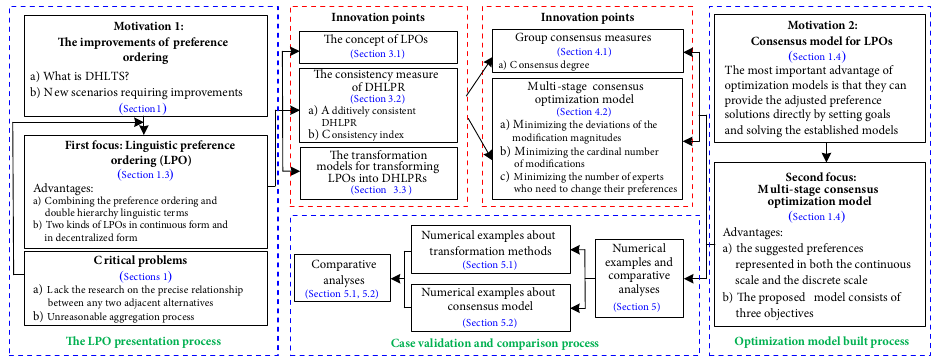
Figure 1. The main work of this